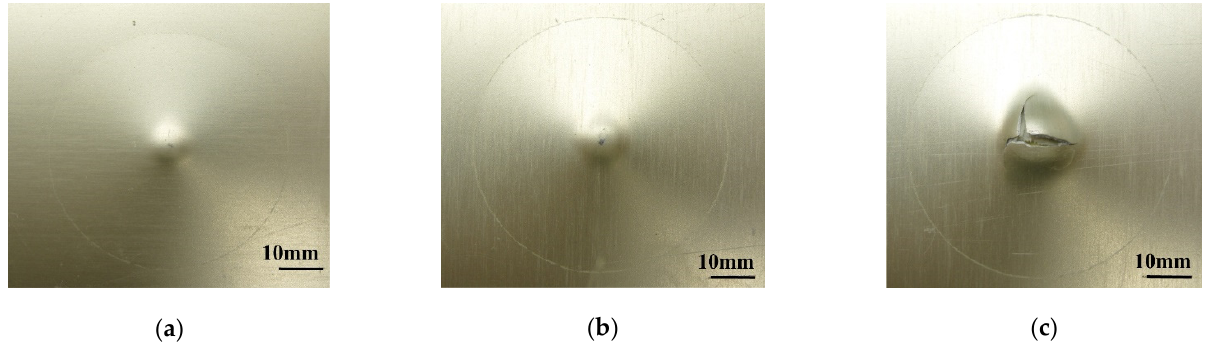
Figure 7. Multiple impact damage of GLARE 5-2/1 at ( a ) BVID (8 J (2 × 4 J)), ( b ) BVID (16 J (2 × 8 J)), ( c ) CVID (26 J (2 × 13